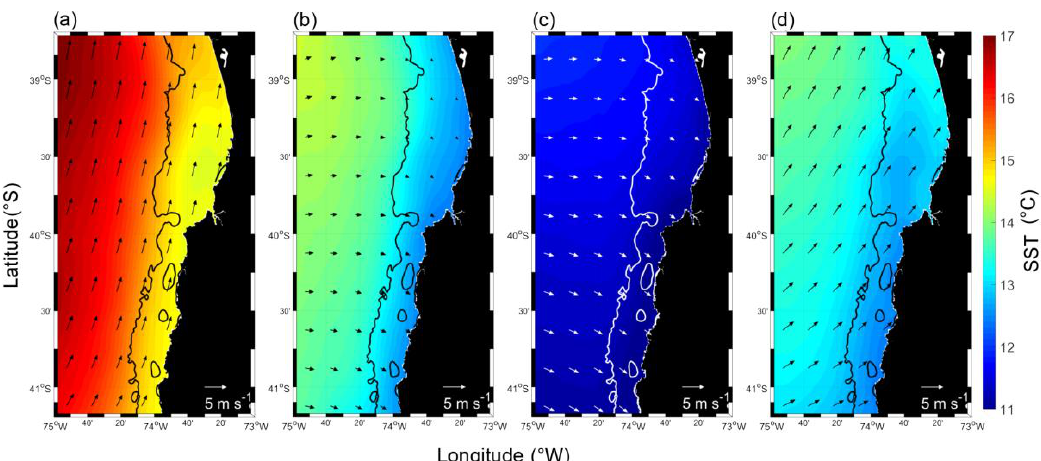
Figure 5. Long-term averages of SST (color, °C) and SSW (black vectors, m s − 1 ): austral summer ( a ), autumn ( b ), winter ( c ), and spring ( d ). At the bottom of each panel is an arrow indicating the wind scale. The boundary of the continental shelf is indicated with the 200 m isobath (black lines are for summer, autumn, and spring, and white lines are for winter) and was obtained from ETOPO2 v2 [25].